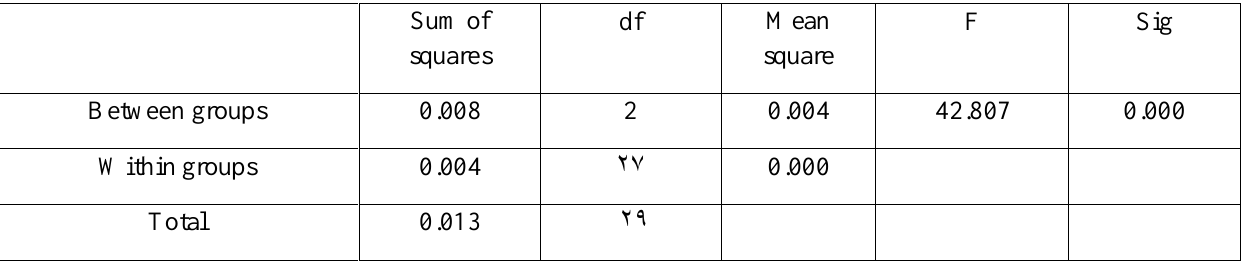
Table 10: One way ANOVA test of water solubility test (mg/cm 2 )